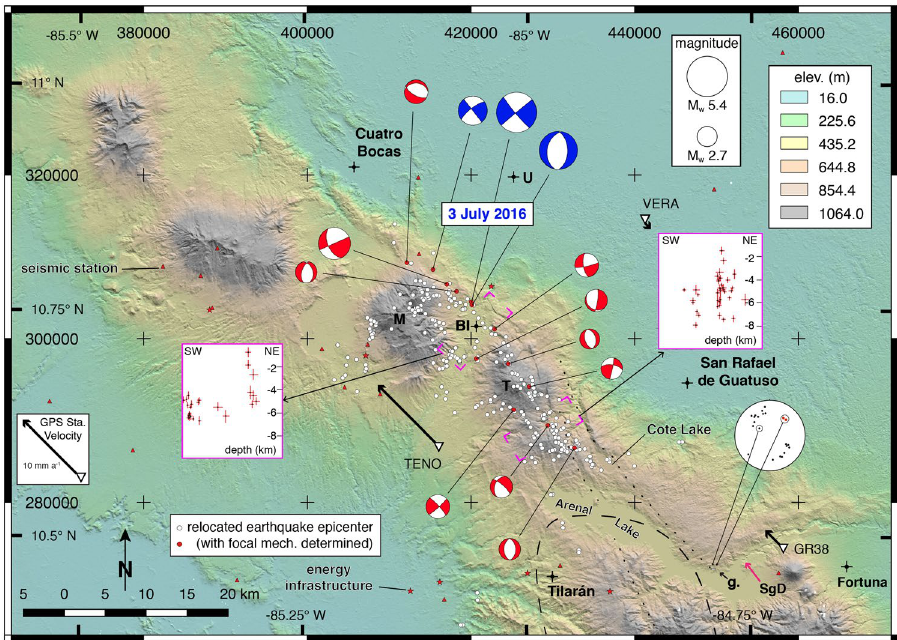
Figure 2. Seismotectonic setting. Geographic reference system here and in Fig. 3 is that found on most topographic maps of Costa Rica, the Ocotepeque 1935/Costa Rica Sur. Latitude and longitude graticules using the WGS 84 reference frame also shown here and in Fig. 3. Digital elevation model and shaded relief map derived from enhanced Shuttle Radar Topography Mission (SRTM) data with an effective resolution of 30 m. Lighting from 020°. Lower-case bold letter g. with view direction for photograph at Fig. 4g. The stereonet shows poles to faults at the outcrop at location g. The red poles show the geometry of the bounding strike- slip fault, the principal displacement zone 27 at the eastern end of the exposure (right end of white symbol), whereas the black poles show normal faults that record dip separations that average ~0.6 m. The circled black pole is the westernmost fault. Portions of the Cote-Arenal fault and Chiripa faults from Fig. 3 are included as a dotted line. The dashed line outlines the aftershock area for the 13 April 1973 M s 6.5 Tilarán earthquake 29 . The dashed magenta boxes show the locations of the two inset seismicity profiles in which the uncertainty in the earthquake locations is shown by vertical and horizontal red lines. Towns are shown with a dot-plus symbol. Town abbreviations: BI = Bijagua and U = Upala. Volcanoes: M = Miravalles and T = Tenorio. SgD with red arrow = Sangregado Dam. Map generated using QGIS version 2.14 with SRTM 1 Arc-Second Void Filled digital elevation data courtesy of the U.S. Geological Survey from https://earthexplorer.usgs.gov/. Keys, labels and symbols were added using Adobe Illustrator CC 2015